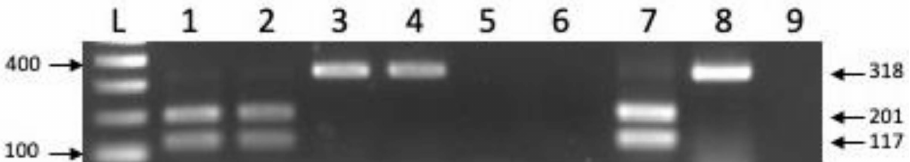
Figure 2. Phylogenetic clade differentiation of grapevine red blotch virus (GRBV) isolates via restric- tion digestion. PCR amplicons of the GRBV replication ORF were digested by AleI-v2 and resolved by agarose gel electrophoresis and GelRed staining. Amplicons obtained from the vines infected with a GRBV clade 1 isolate were cut into two bands, approximately 201 and 117 bp in length, while those obtained from the vines infected with a GRBV clade 2 isolate remained uncut at 318 bp in length. Lanes 1 and 2, GRBV clade 1-infected grapevines from a California vineyard; lanes 3 and 4, GRBV clade 2-infected grapevines from a California vineyard; lane 5, a healthy grapevine from a California vineyard; lane 6, no template control; lane 7, a GRBV clade 1-infected potted grapevine in a greenhouse following Agrobacterium tumefaciens -mediated inoculation; and lane 8, a GRBV clade 2-infected potted grapevine in a greenhouse following A. tumefaciens -mediated inoculation. Lane L: 100 bp molecular weight